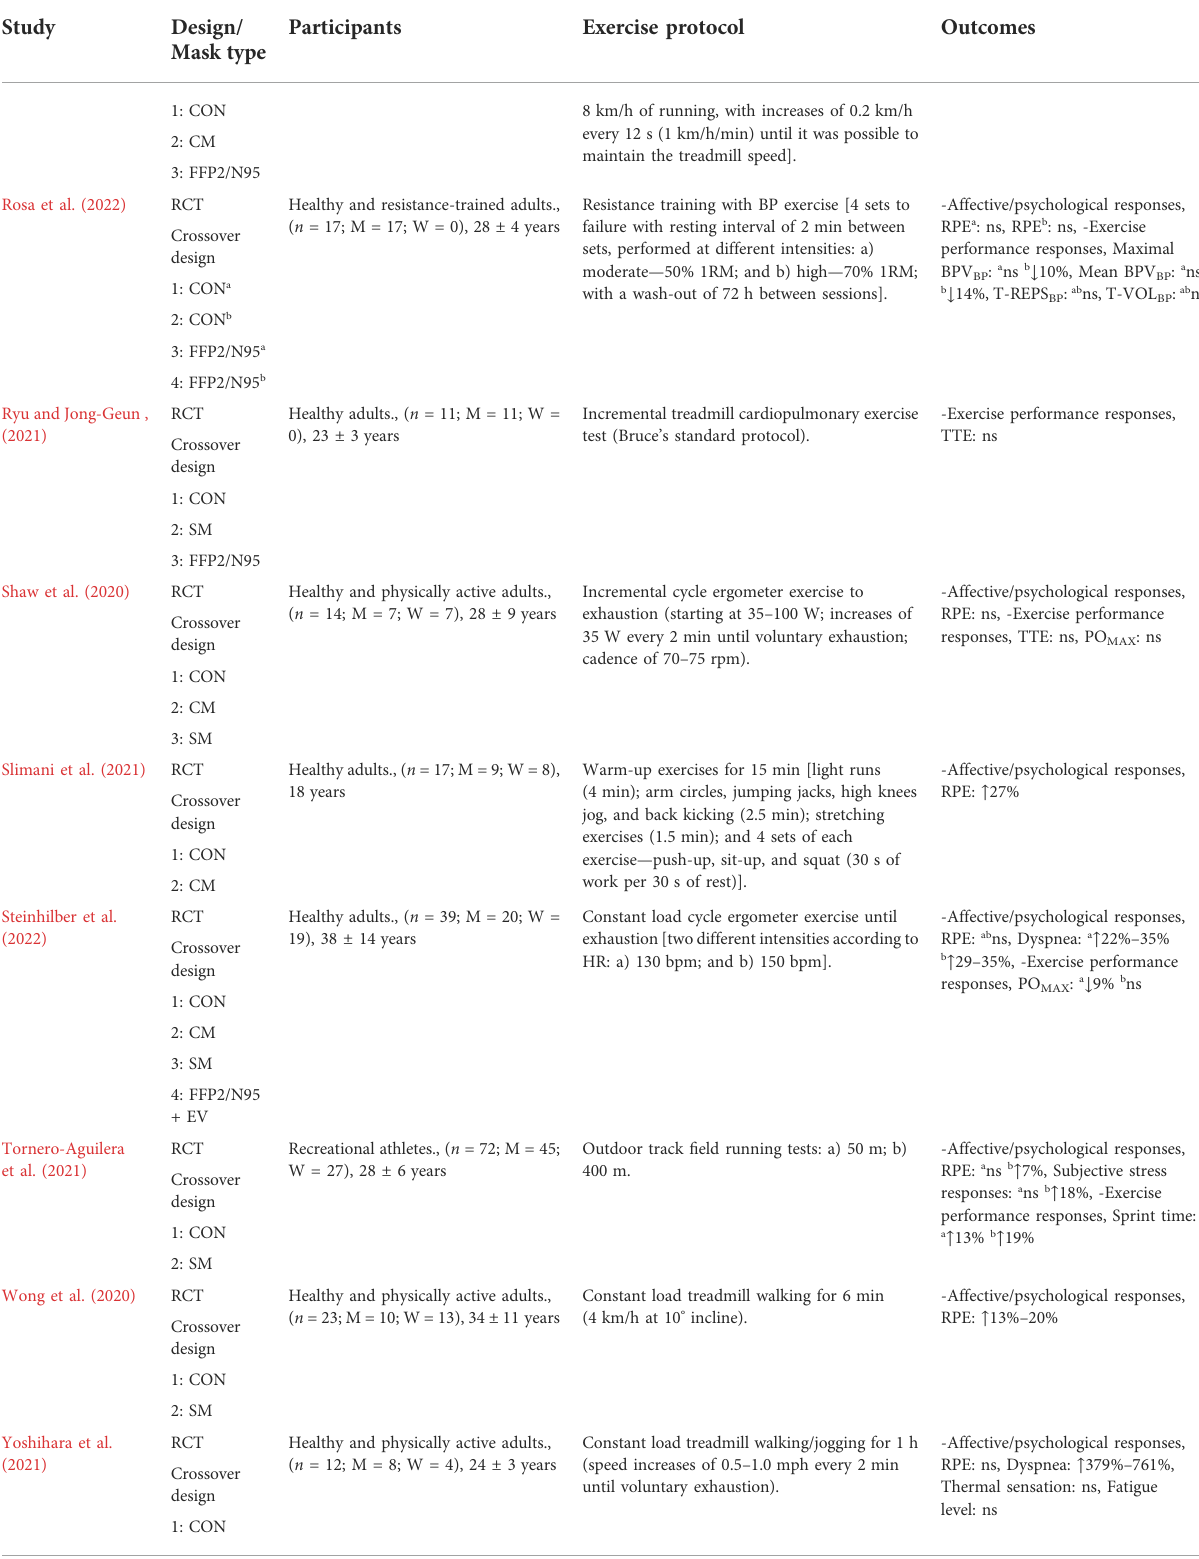
TABLE 1 ( Continued ) Summary of studies on the acute effects of comparison between use of mask versus no-mask wearing during